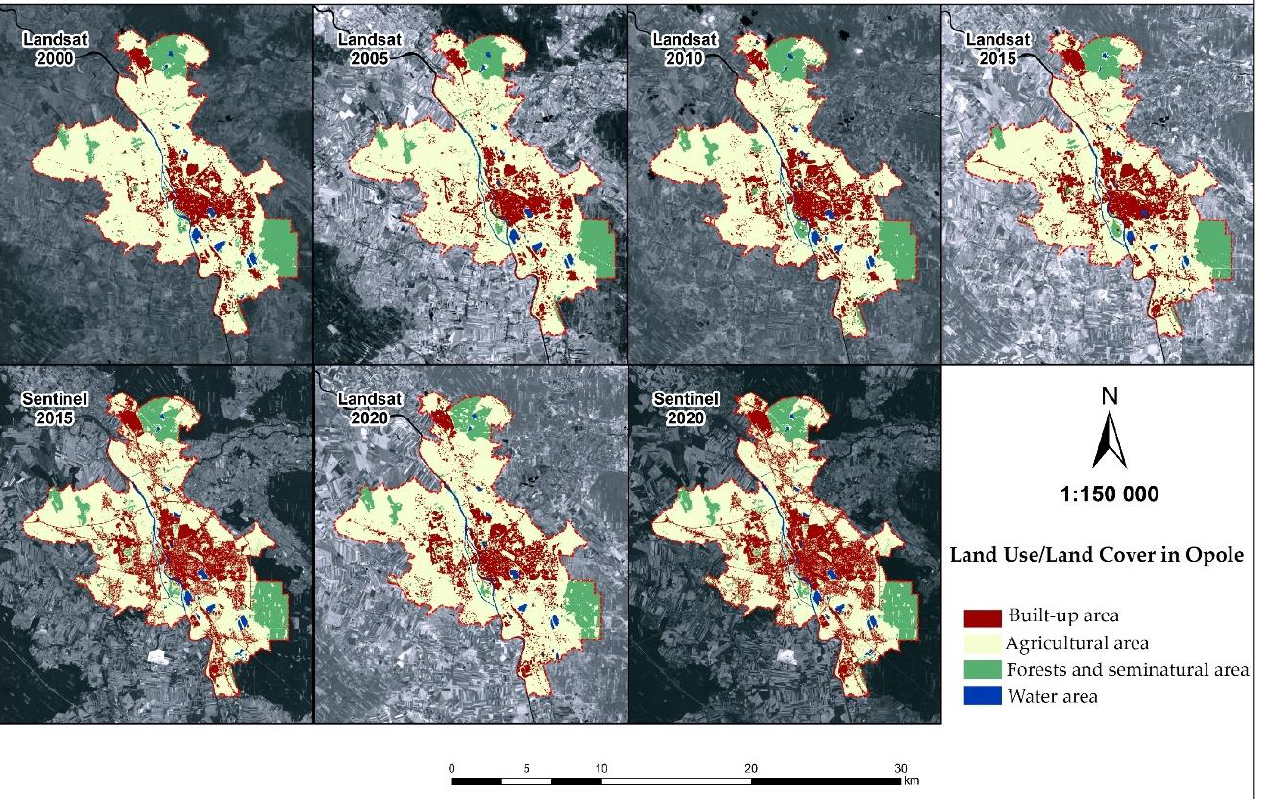
Figure 2. Classified land cover maps of Opole produced from the supervised classification of Landsat (2000, 2005, 2010, 2015, 2020) and Sentinel (2015, 2020). Table 2. Land use and land cover (LULC) in Opole obtained on the basis of processing of satellite imagery: Landsat (2000, 2005, 2010, 2015, 2020) and Sentinel (2015, 2020), source: [84]. LULC Units ha 2291.05 Built-up area ha Agricultural area Forests and semi-natural